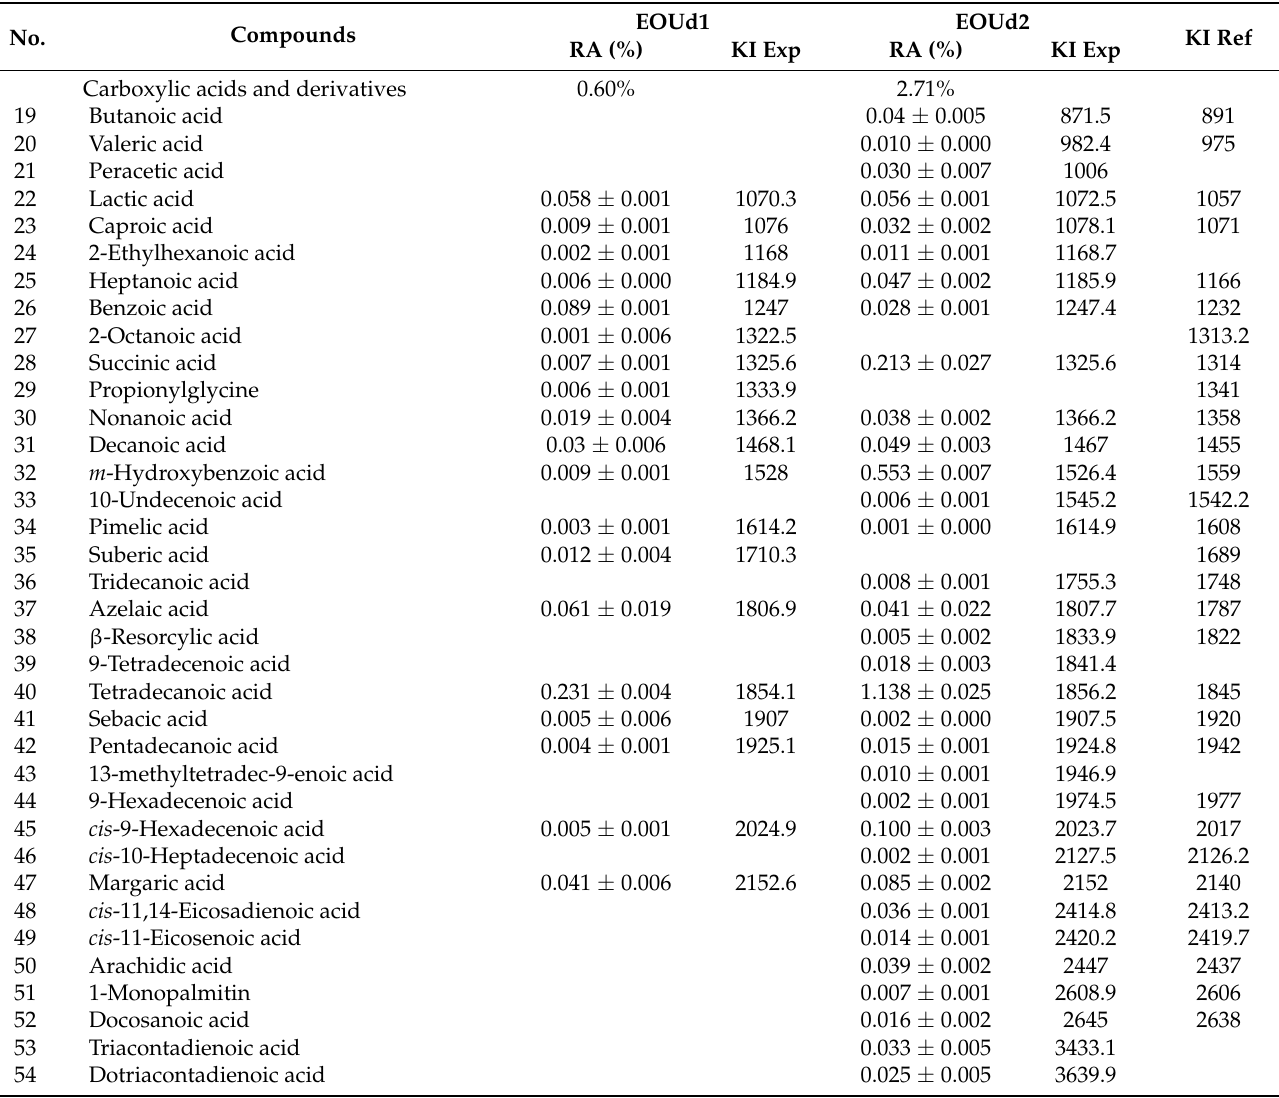
Table 4. Identified compounds of U. dermestoides essential oils derivatized by